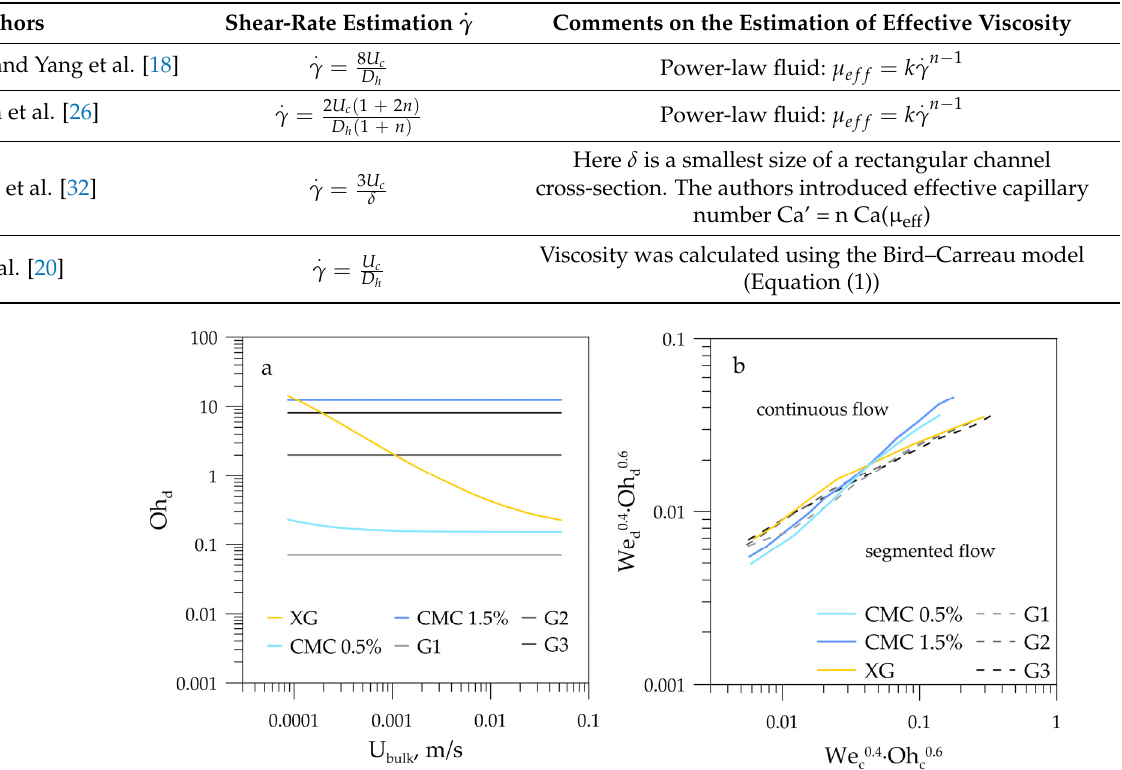
Table 3. Different approaches to shear-rate estimation in two-phase microfluidic flows.